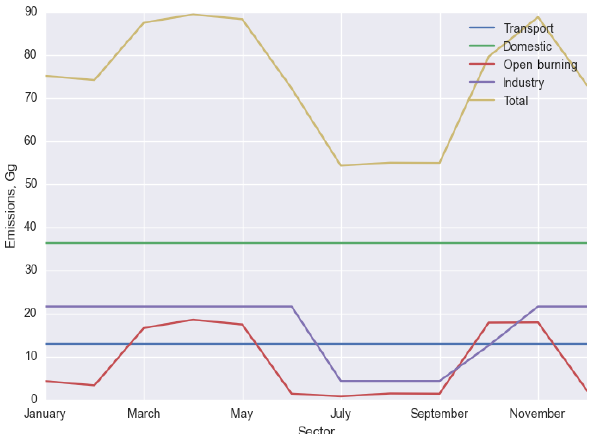
Figure 13. Time series of monthly emissions for India, 2011. Note the strong seasonality of the open-burning and industry sector. In the latter case, the seasonality results predominately from sugarcane